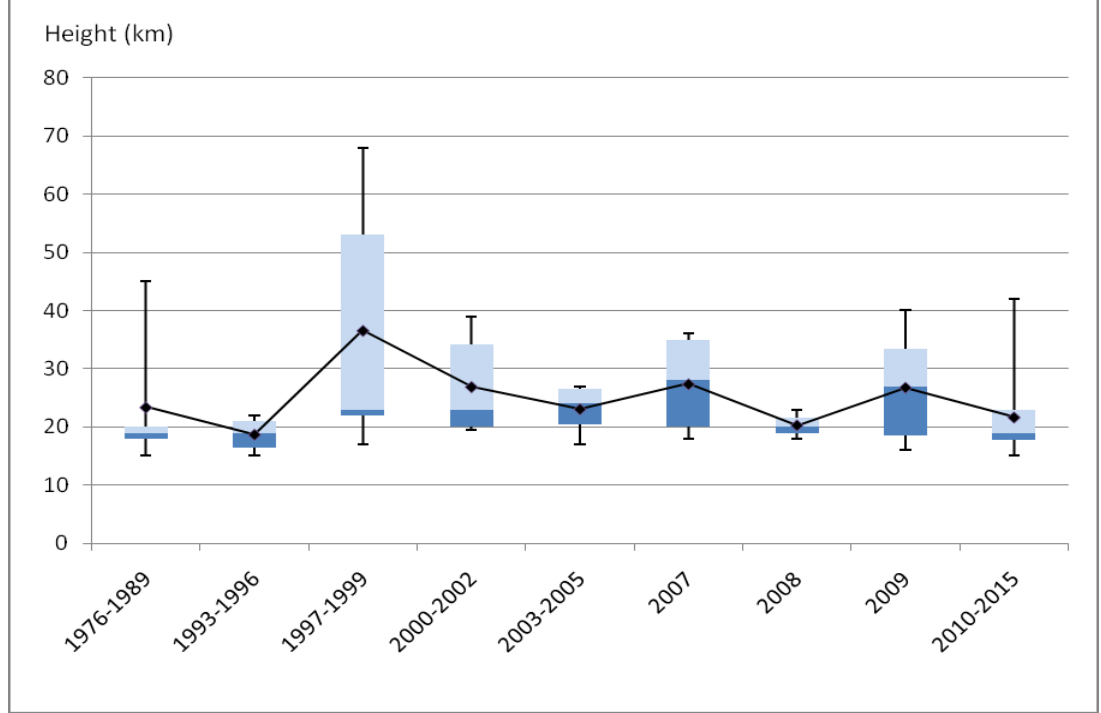
Figure 6. Box-and-whisker plot of the longest transfer sewers in Finland in 1976–2015